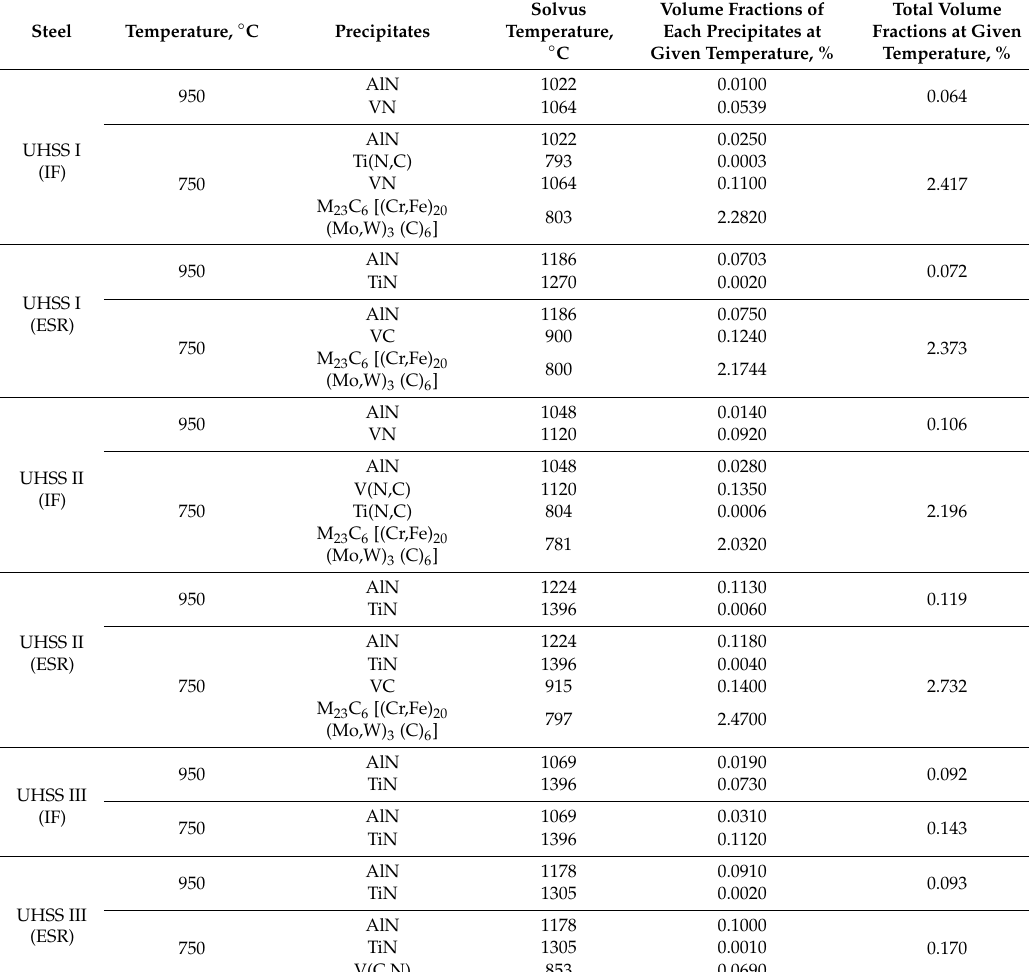
Table 5. Solvus temperatures and the volume fractions of precipitates in equilibrium at 950 ◦ C and 750 ◦